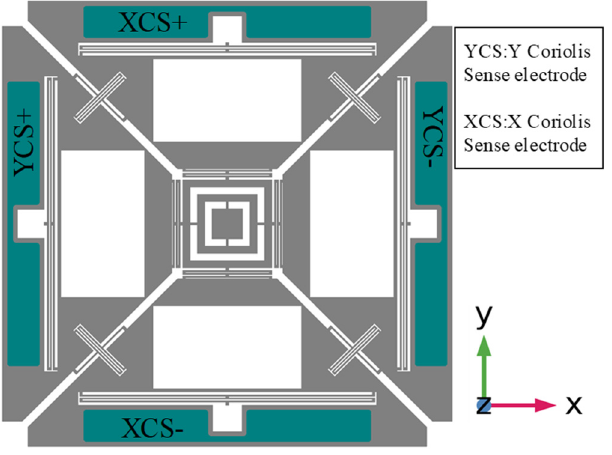
Figure 3. Bottom Electrode Layers of the Designed MEMS Gyroscope.